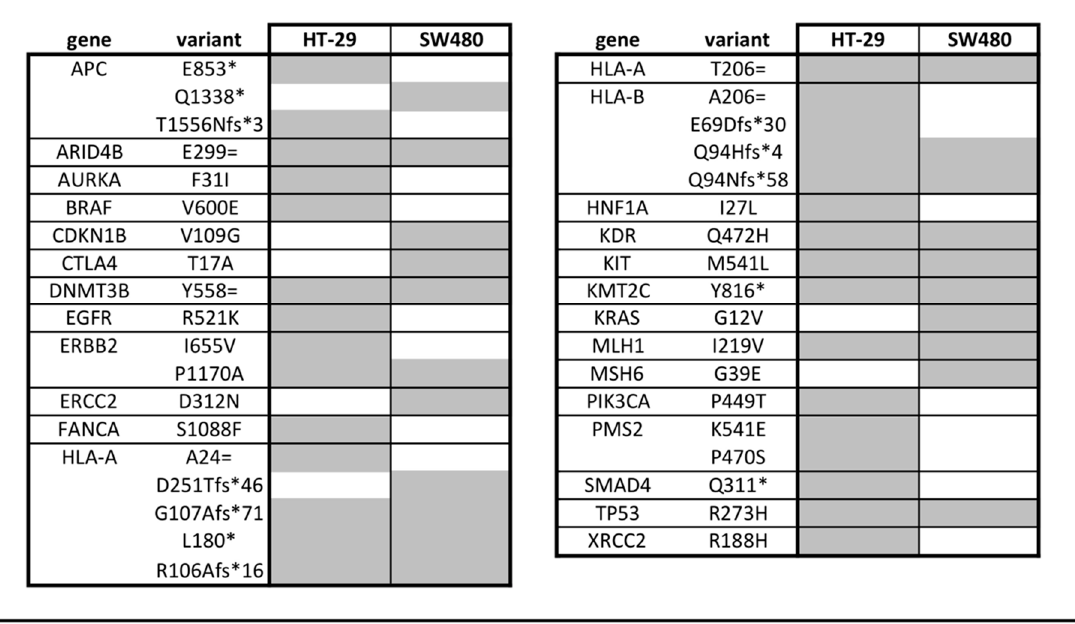
Figure 7. Mutation profile of HT-29 and SW480 cell lines was analyzed by exome sequencing. Intronic variants were excluded, and mutated genes considered as likely oncogenic on the basis of the OnkoKB database were shown. Grey color indicates gene